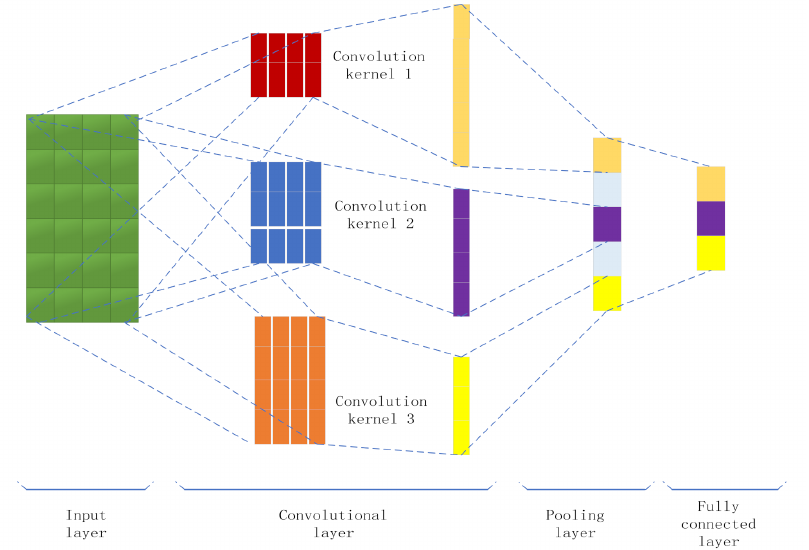
Figure 5. CNN structure diagram of multiple convolution